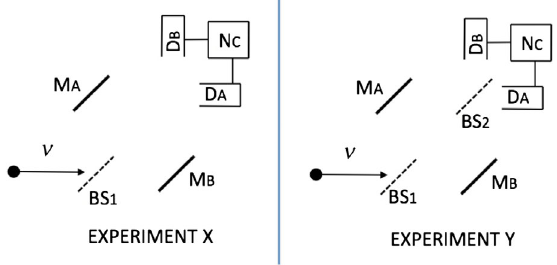
FIG. 7. In each of these two experiments X (one beam splitter) and Y (two beam splitters), a single photon ( ν ) is sent to the right through the apparatus. M ¼ Mirror, BS ¼ Beam splitter, ¼ Coincidence counter. D ¼ Detector, N C